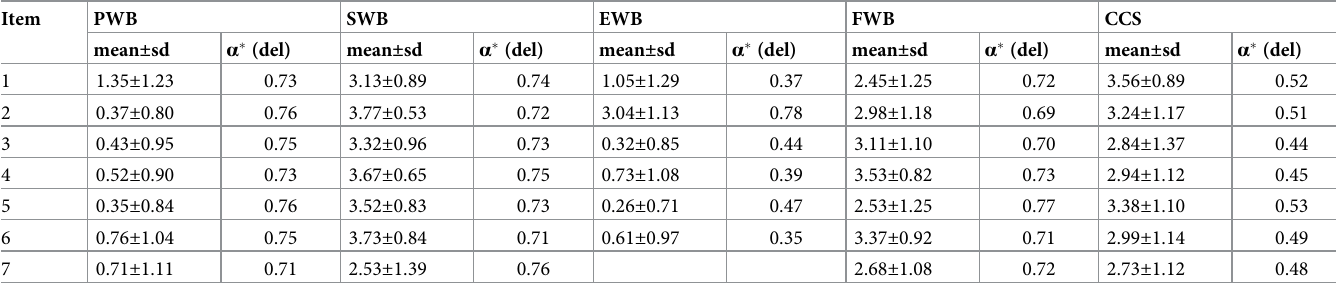
Table 3. Mean values, standard deviation and corrected Cronbach’s alpha coefficients for all the subscales of the Serbian FACT-C questionnaire. Item